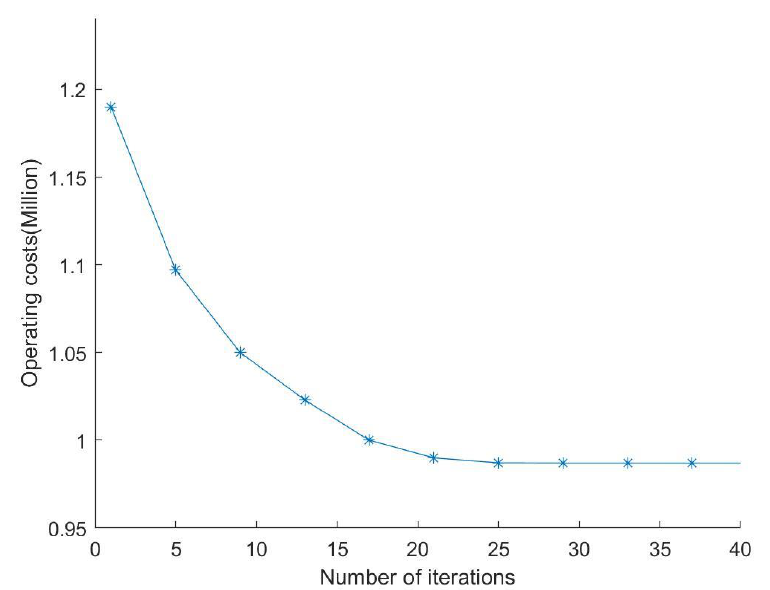
Figure 12. Results of optimal target and operation index of VMG, DSO in two optimal methods.